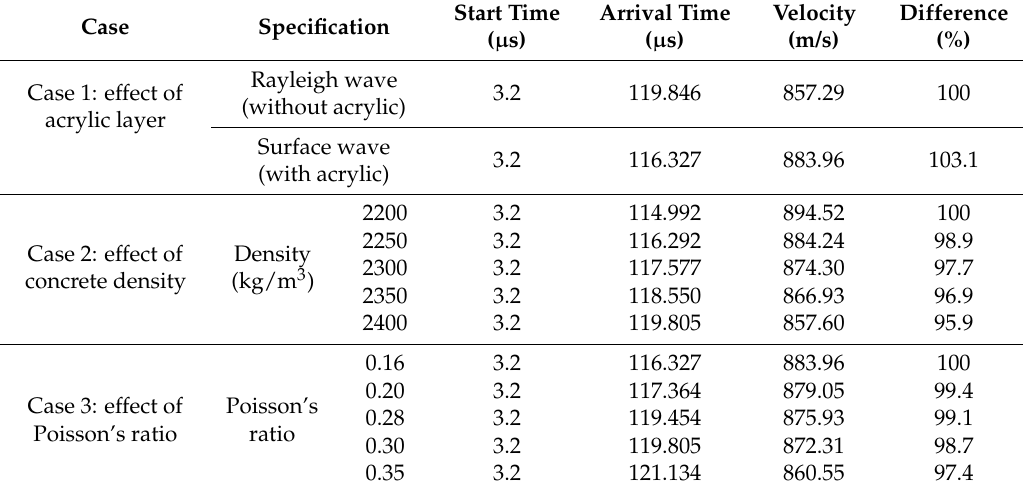
Table 1. Comparison of wave velocity from FE